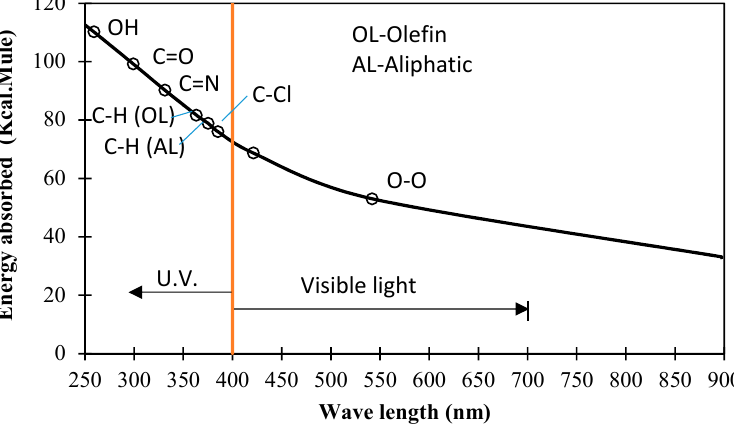
Figure 17. Representative chemical bond keys and their absorption energies.